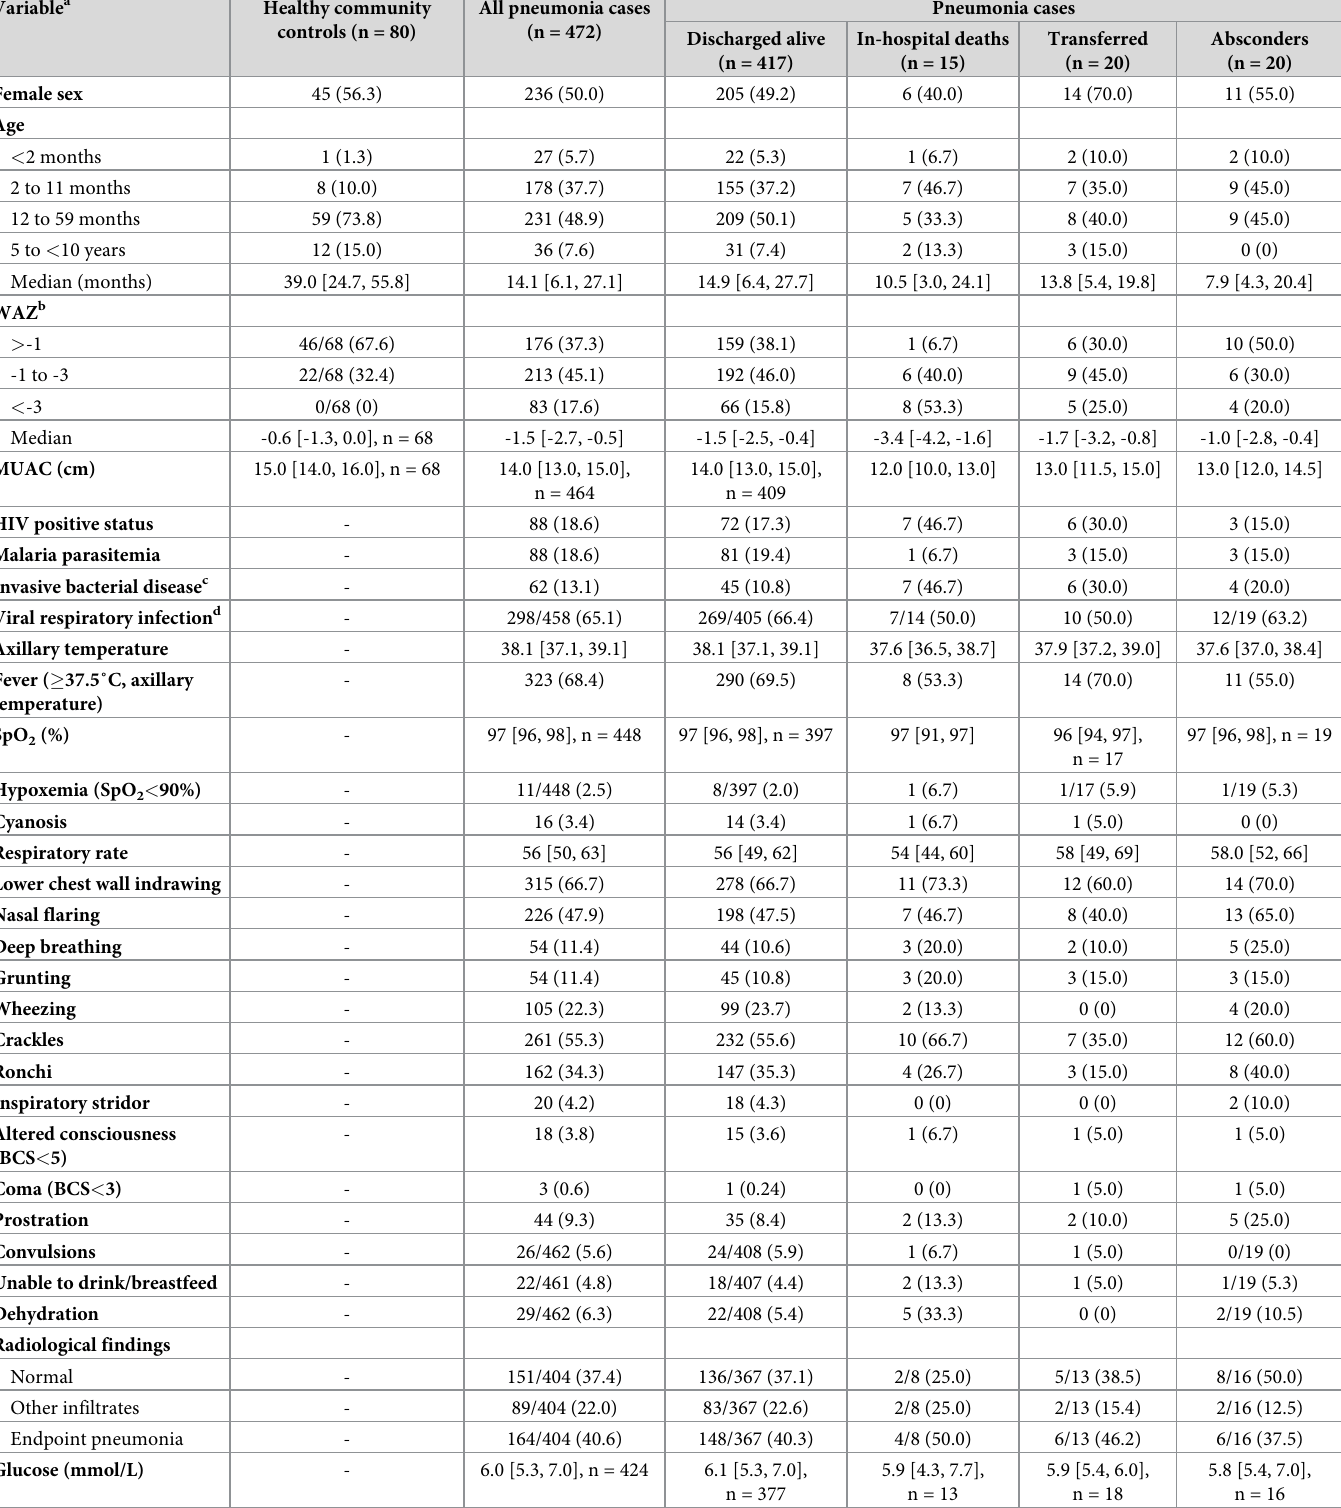
Table 1. Demographic and clinical characteristics of the study